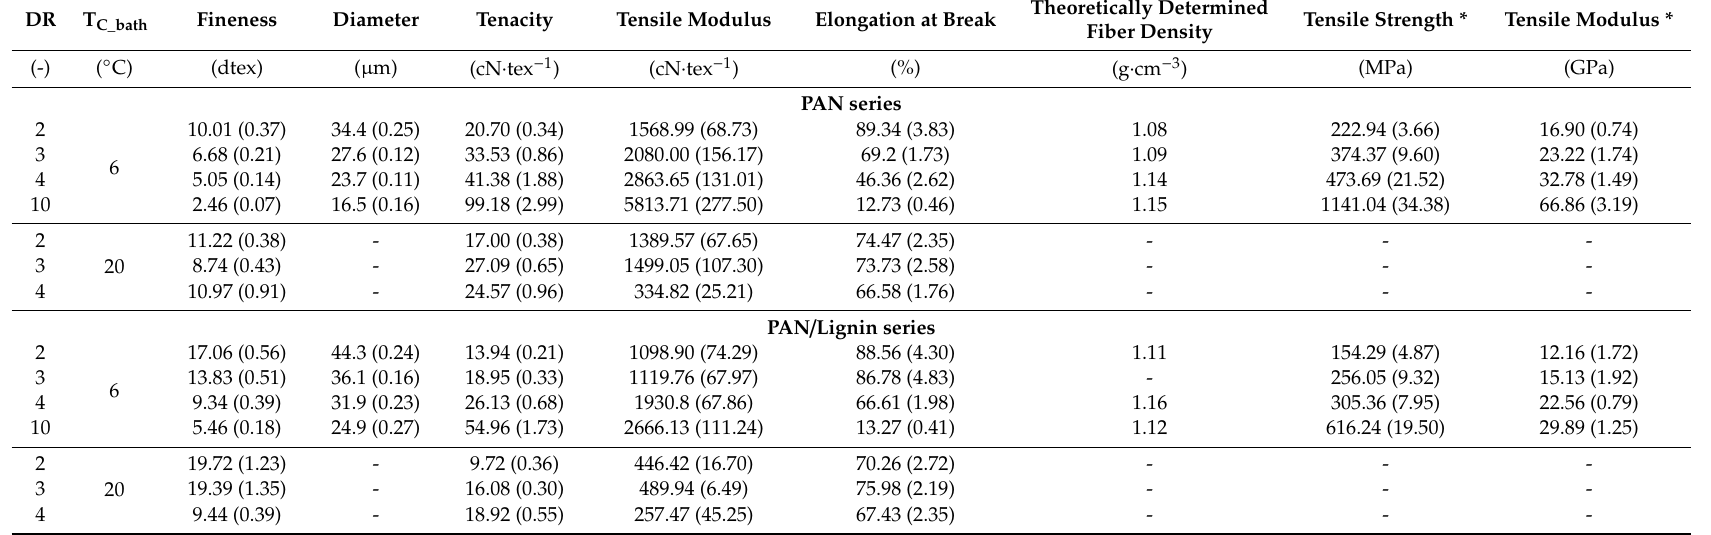
Table 3. The impact of the processing parameters (drawing; temperature of the coagulation bath) on the mechanical performance of the developed fibers. Data in brackets represent the standard error. * Data based on the diameter mean values and tenacity mean